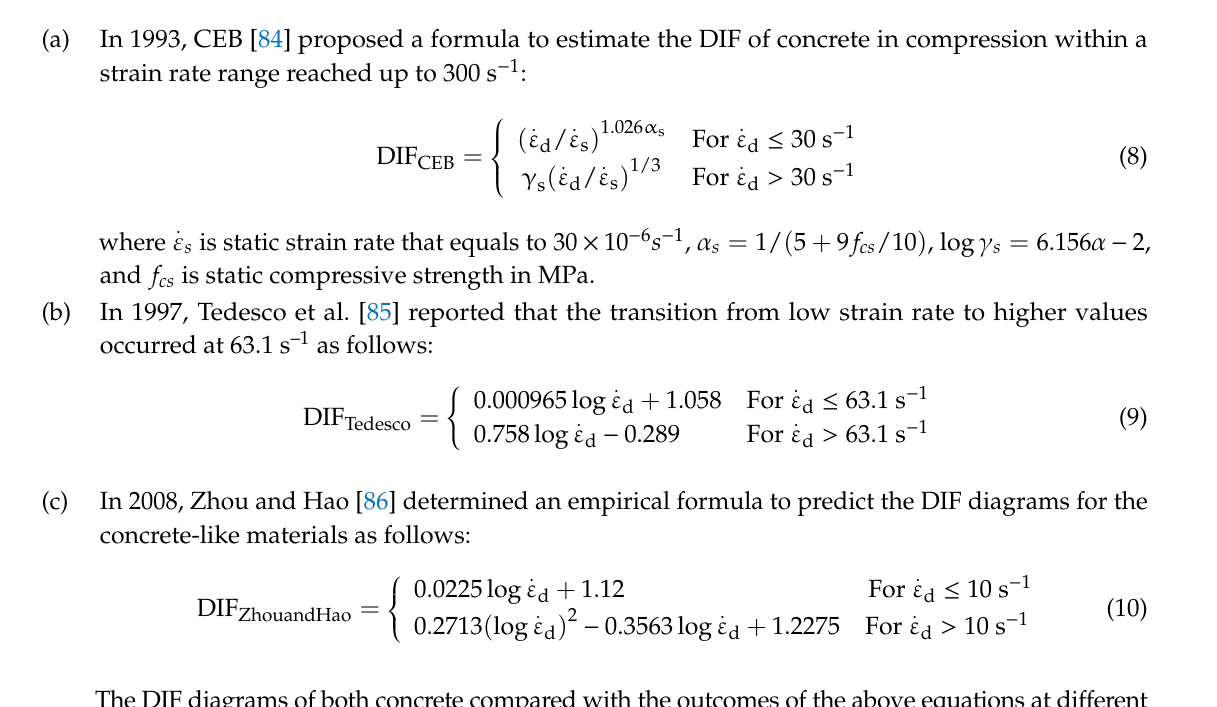
Figure 12. Plots of normal probability and predicted vs. actual values: ( a ) PC and ( b ) HVFANS